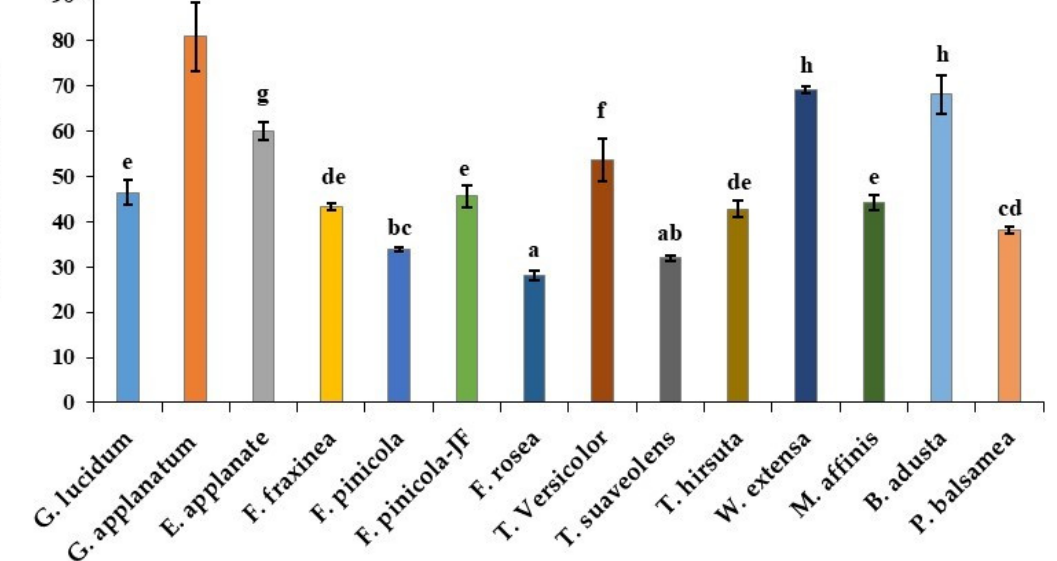
Figure 1. Linear growth measurement of the Polyporales species. Each value is the mean of three individual triplicate experiments ( ± SD), and species with the same letter do not differ significantly by the Duncan test, ( p < 0.05). ( p < 0.05)—the lower case letter: p -value less than 0.05; mm – millimeter.